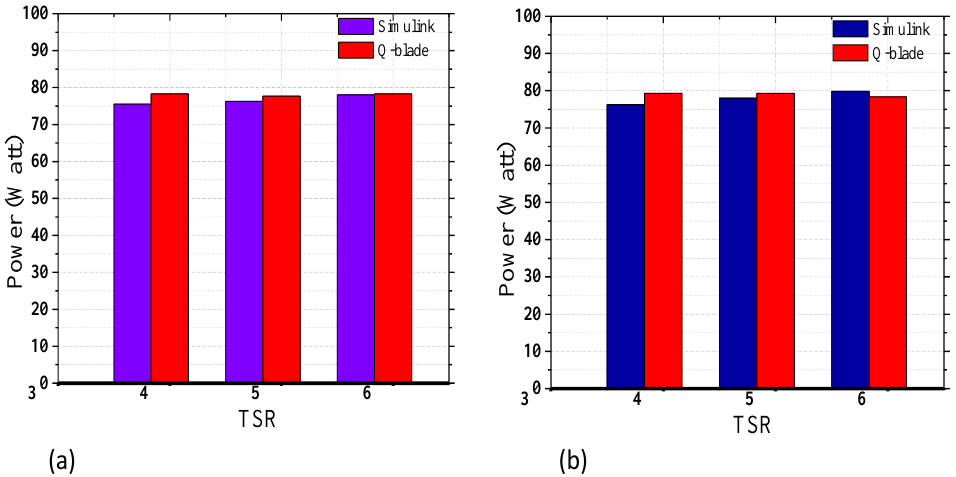
Figure 24. Compared power output at design wind speeds obtained with Q-blade and MATLAB/ Simulink for ( a ) NACA 4412 rotor blade ( b ) SG6043 rotor blade.